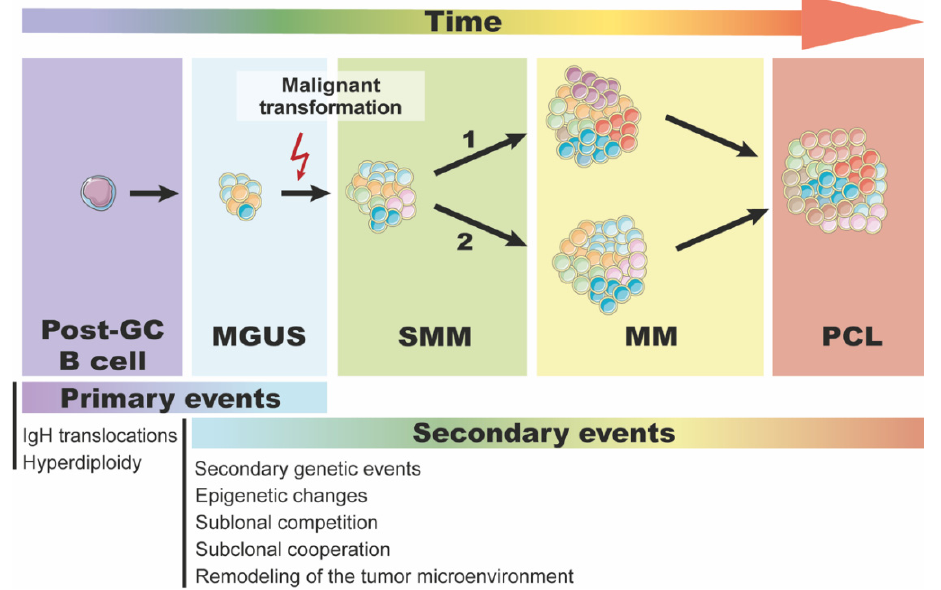
Figure 1. Evolution of plasma cell dyscrasias. Both primary and secondary genetic events are re- quired for malignant transformation of a post-GC B cell to MM. New genetic events accumulate in malignant plasmocytes over time affecting the fitness of subclones and leading to further expansion of some and to the extinction of others. Progression from MGUS/SMM to MM is driven by subclonal competition (and likely by its cooperation) and by simultaneous changes in the tumor microenvi- ronment. (1) Branching clonal evolution—the dominant evolutionary pattern in the progression of SMM to MM, with some subclones disappearing (pink, light blue) and others appearing (red, purple, brown) over time; (2) static clonal progression—evolutionary pattern in the progression of SMM to MM, in which the tumor’s subclonal architecture does not change significantly over time. Abbreviations: GC, germinal center; IgH, immunoglobulin heavy chain; MGUS, monoclonal gammopathy of undetermined significance; MM, multiple myeloma; SMM, smoldering multiple myeloma; PCL, plasma cell leukemia. The figure was prepared using images provided by Servier Medical Art (https://smart.servier.com accessed on 23 August